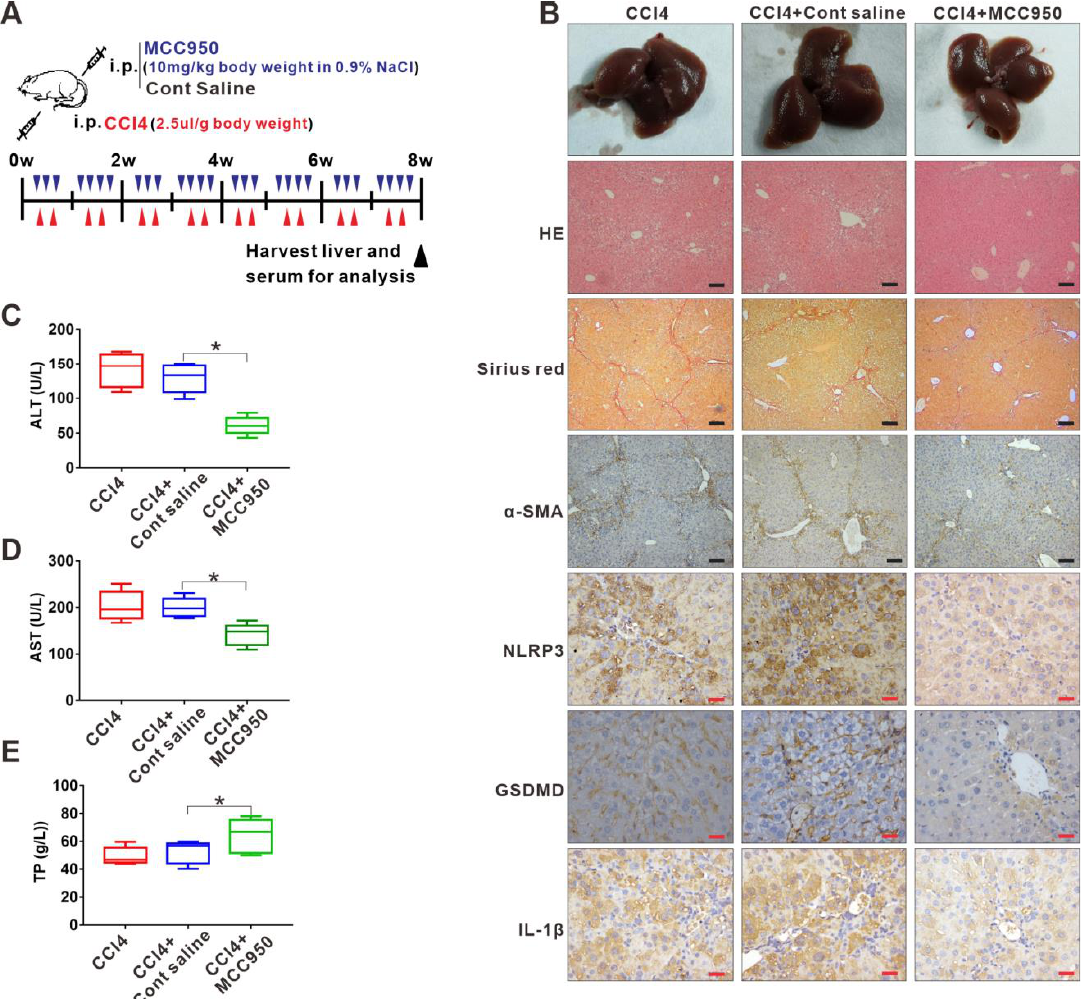
Figure 2. Inhibition of NLRP3 inflammasome-dependent pyroptosis alleviates liver fibrosis progression. (A) Experimental protocol of NLRP3 inhibitor MCC950 or saline application based on CCl4 injection in mice. (B) Representative liver histology of H&E and Sirius Red staining. The expression of α -SMA, NLRP3, GSDMD, and IL- 1β was determined by immunohistochemist ry. Black scale bar: 100 µm; Red scale bar: 50 µm. (C – E) Serum levels of ALT, AST, and TP were measured. * p <